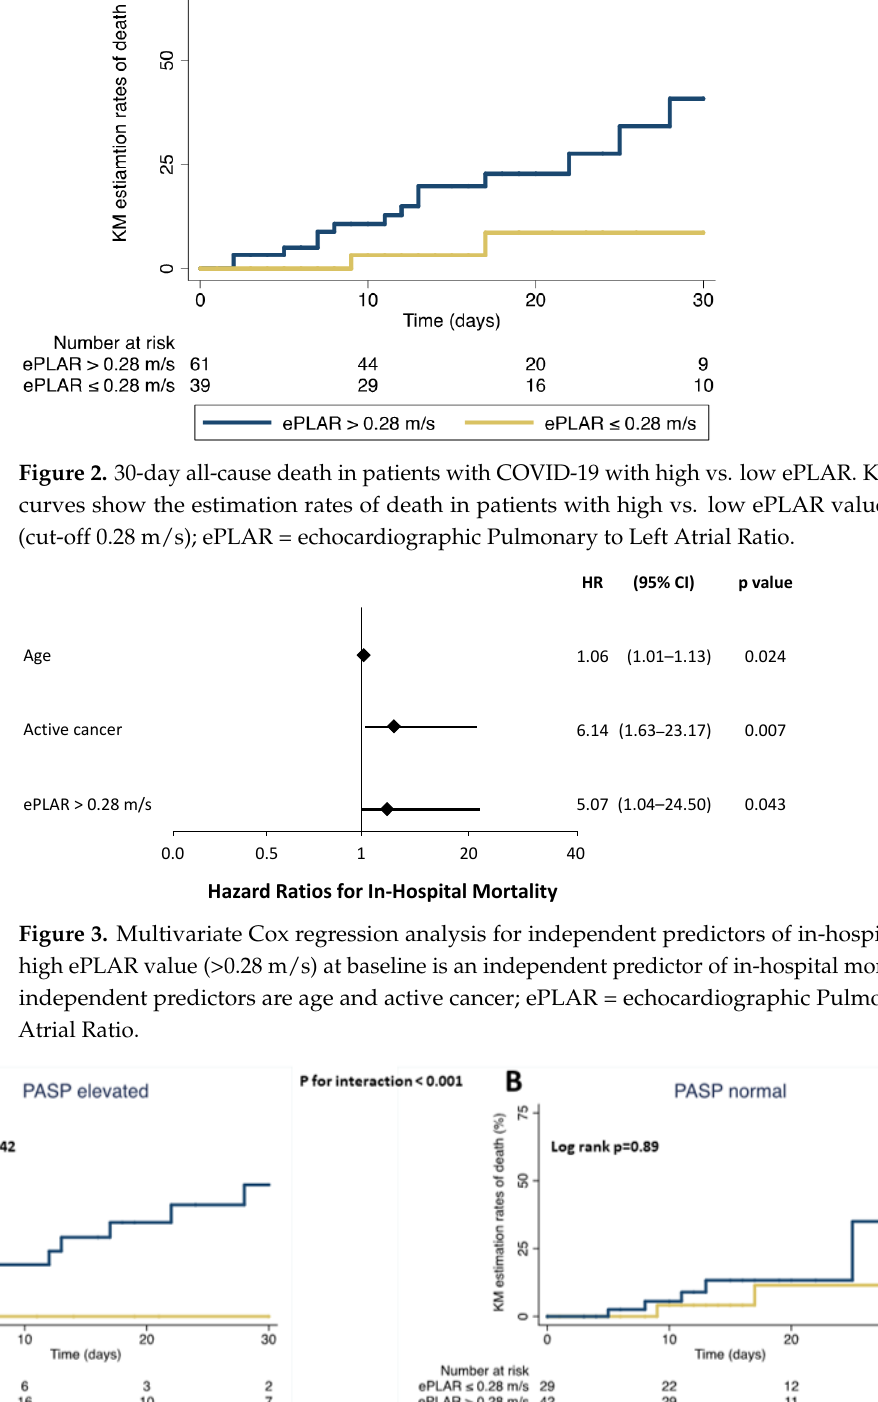
high ePLAR value (>0.28 m/s) at baseline is an independent predictor of in-hospital mortality. Other